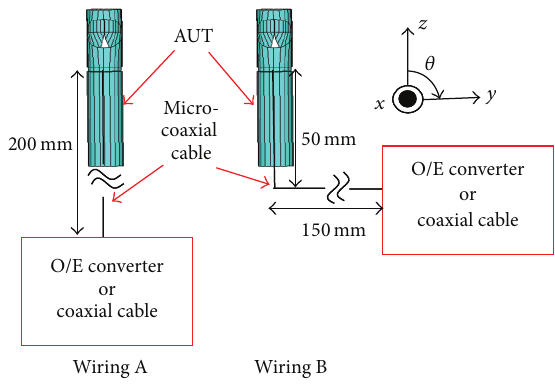
Figure 5: Antennas with two different wirings of micro-coaxial cable.